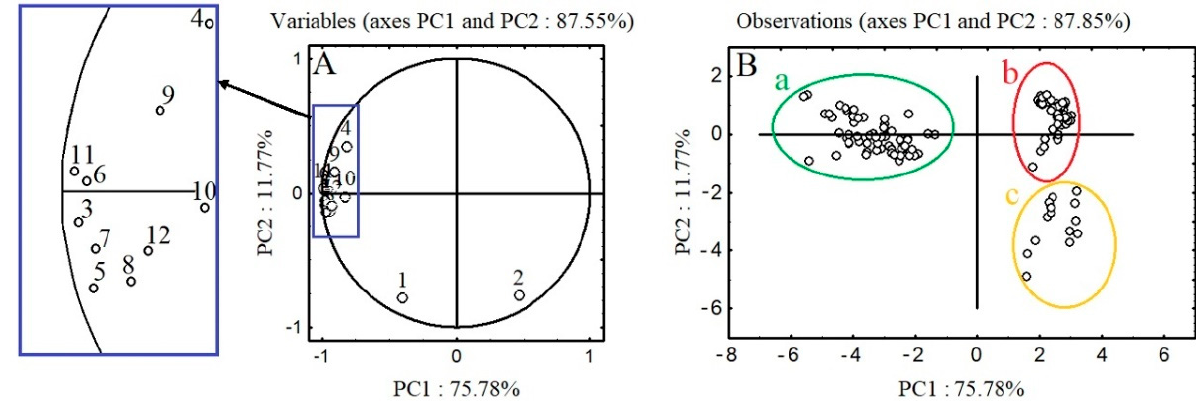
Figure 2. Principal component analysis (PC1 and PC2) of A. eupatoria at five development stages. ( A ) The loading values of response values (polyphenols concentration) on PC1 and PC2 from PCA. ( B ) Observations on the same PCA axes.